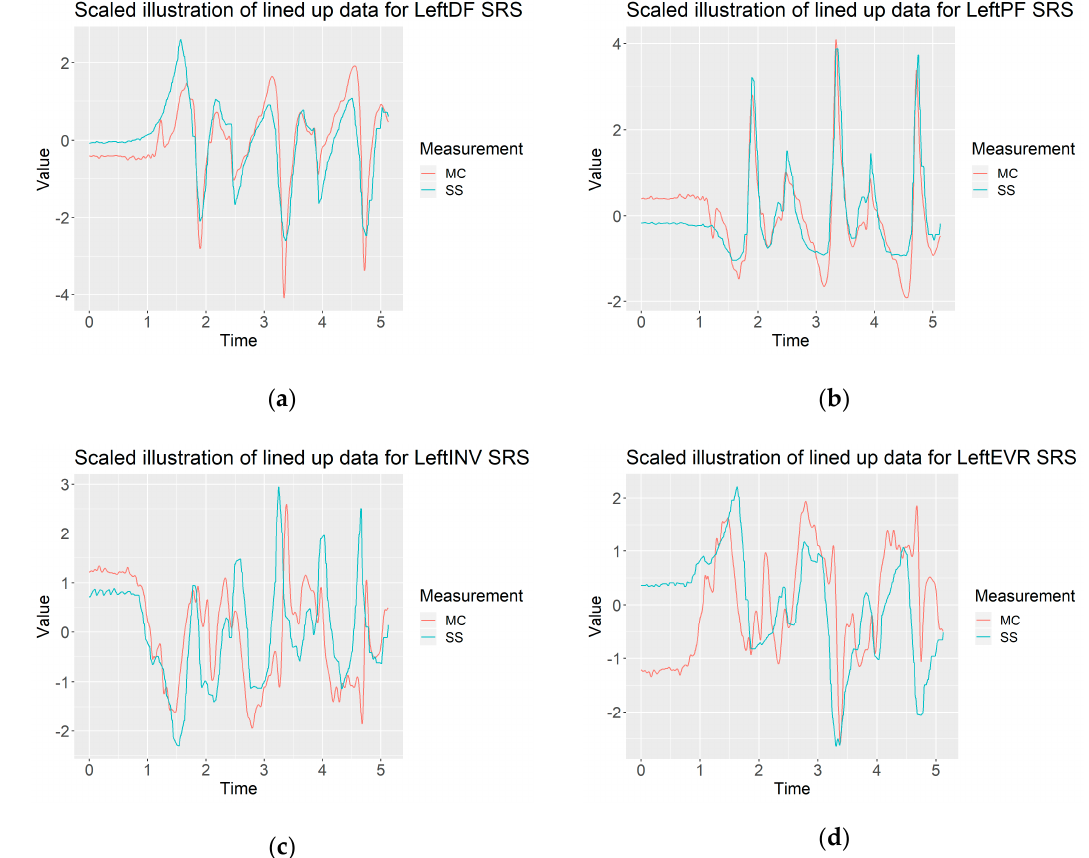
Figure 4. ( a ) Scaled output of StretchSense™ DF sensor output (capacitance) compared to